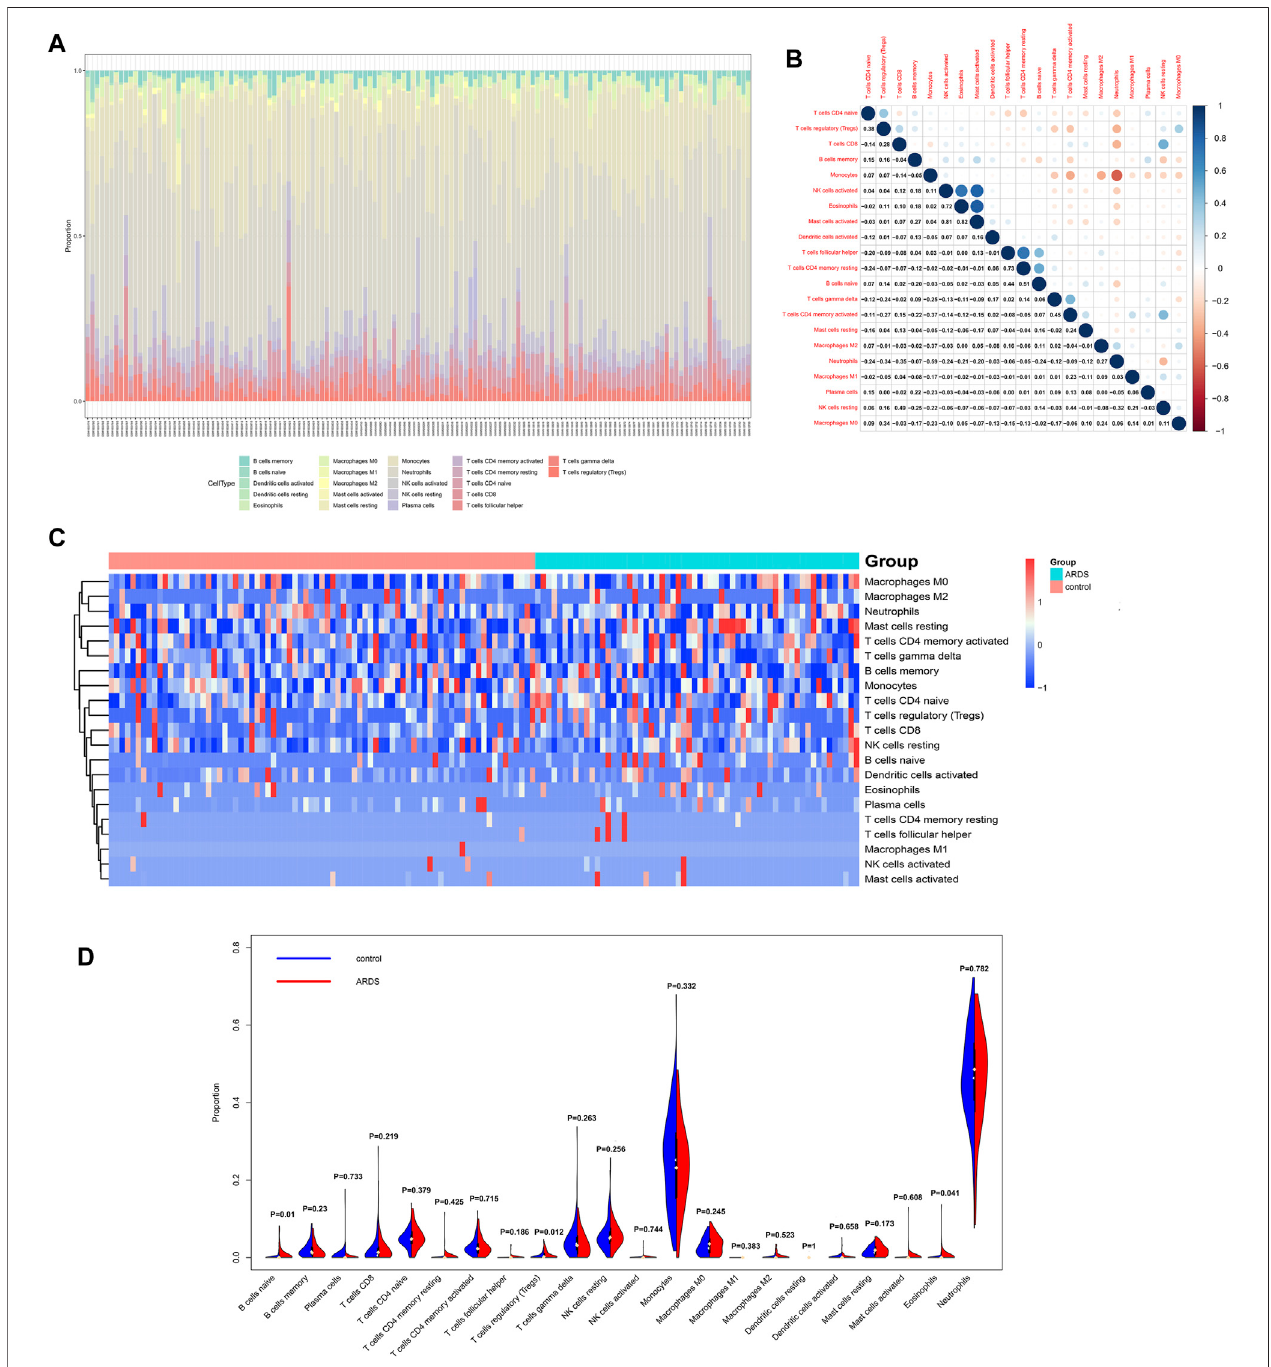
FIGURE 8 | Analysis of 22 subtypes of immune cells in patients with sepsis-induced ARDS. (A) The distribution of immune cell types in total 139 samples. (B) The correlation analysis among 22 immune cell subtypes. (C) The heatmap for in fi ltrating immune cells. (D) The violin plots for in fi ltrating immune cells.